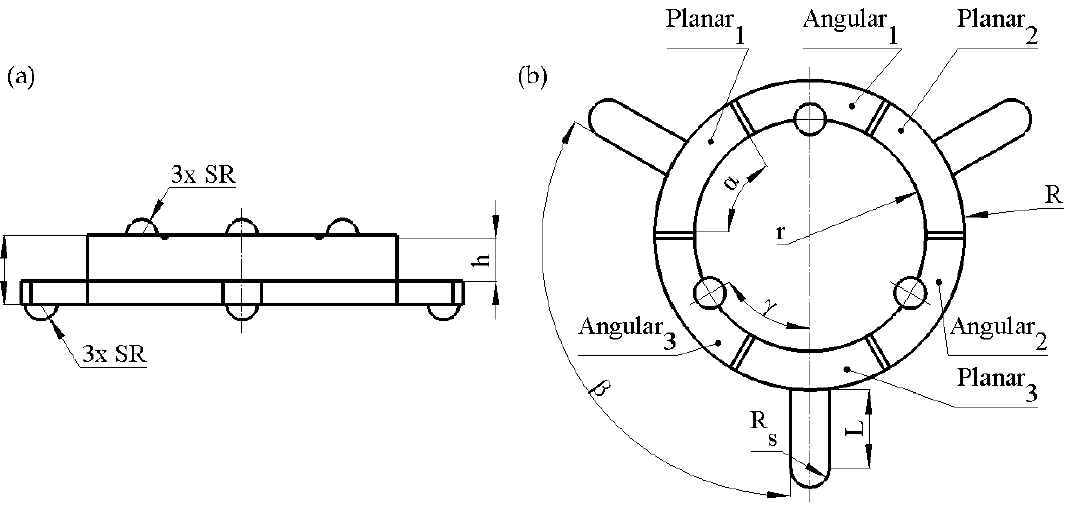
Figure 2. Sketch of the robot; ( a )—side view; ( b )—top view; Planar 1 –Planar 3 are segments of piezo ceramic ring dedicated to control planar motion; Angular 1 –Angular 3 are segments of piezo ceramic ring dedicated to controlling angular motion. Table 1. Geometrical parameters of the robot.